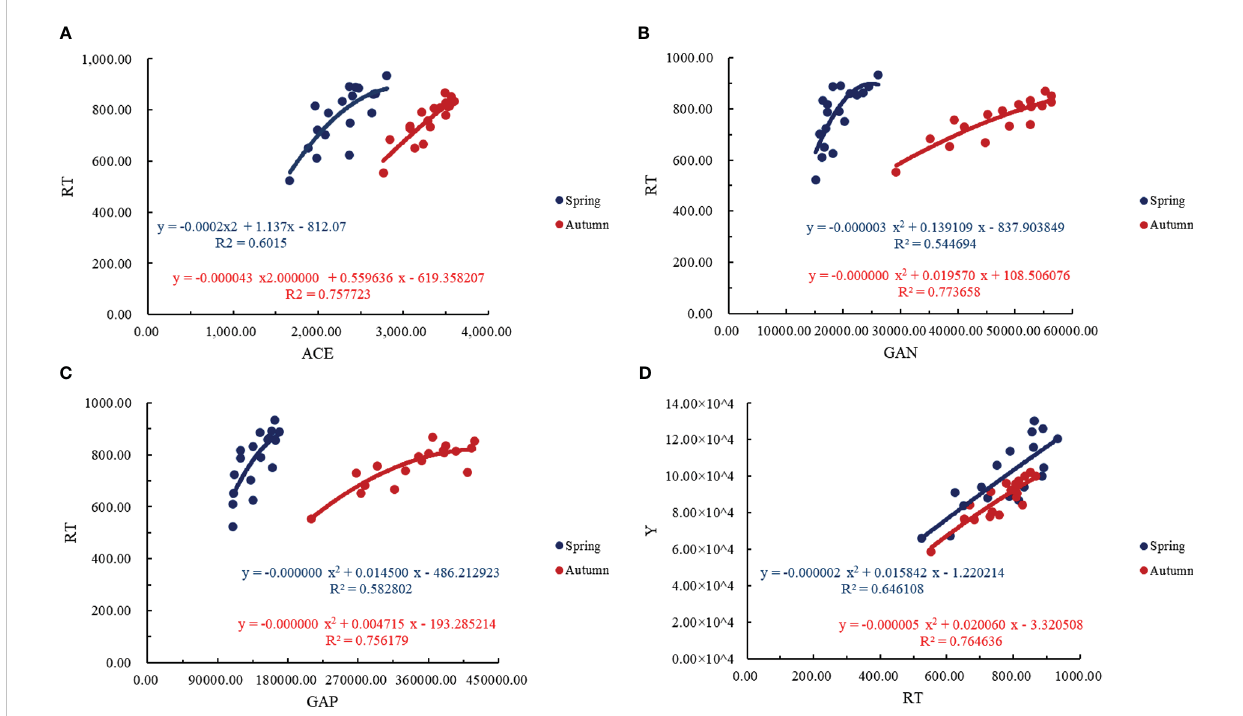
FIGURE 10 Quantitative analysis of tomato soil bacterial community, root system and yield in greenhouse. (A) represents the regression analysis of ACE index of soil bacterial and total number of root tips, (B) represents the regression analysis of soil bacterial nitrogen metabolism functional gene abundance and total number of root tips, (C) represents the regression analysis of soil bacterial phosphorus metabolism functional gene abundance and total number of root tips, (D) represents the regression analysis of yield and total number of root tips. The ACE represents ACE index of soil bacterial, the GAN represents the soil bacterial nitrogen metabolism functional gene abundance, GAP represents the soil bacterial phosphorus metabolism functional gene abundance, the RT represents the total number of root tips, the Y represents the